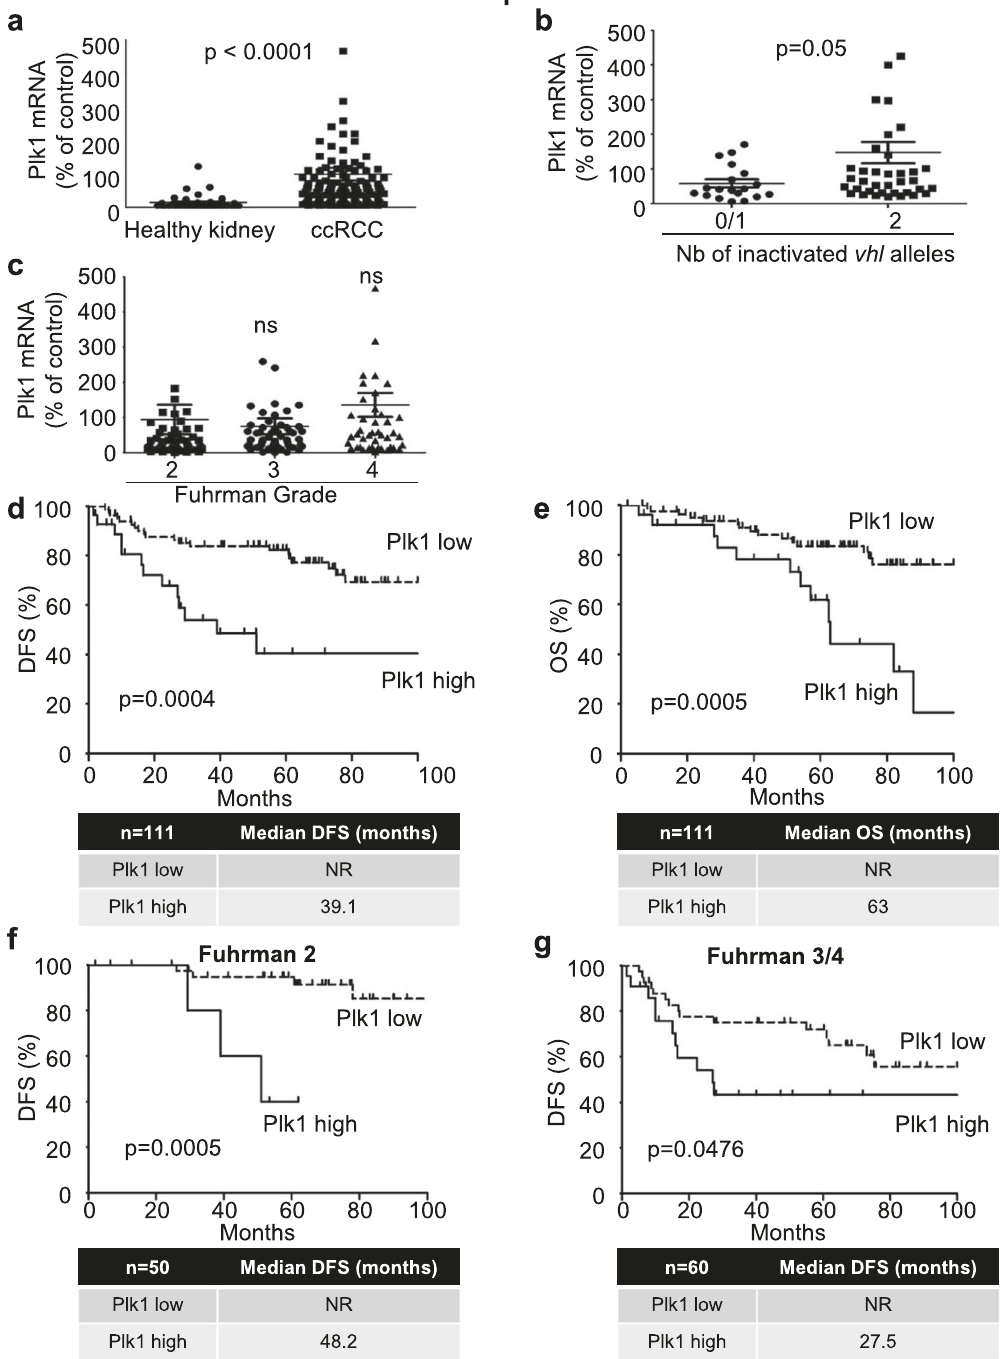
Fig. 1 Plk1 is associated with poor prognosis in ccRCC. 111 M0 ccRCC patients were analyzed for Plk1 mRNA levels in the kidneys (French cohort). a The levels of Plk1 mRNA in healthy kidney were compared with the levels in ccRCC. b The levels of Plk1 mRNA in ccRCC patients with VHL-WT (0 or 1 inactivated vhl allele) were compared to the levels in ccRCC patients with VHL-inactivated (2 inactivated vhl alleles). Vhl allele inactivation corresponds to a deletion, a mutation, or to a methylation of the promoter. c The levels of Plk1 mRNA were analyzed in different Fuhrman grade group (2 – 4). d , e The levels of Plk1 mRNA in 111 non-metastatic ccRCC patients correlated with DFS ( d ) or with OS ( e ). f , g The levels of Plk1 mRNA in non-metastatic low-grade (Fuhrman 2, f ) or high-grade (Fuhrman 3 and 4, g ) ccRCC patients correlated with DFS. The third quartile value of Plk1 expression was chosen as a cut-off. For ( a – c ), statistics were determined using an unpaired Student ’ s t test. For ( d – g ), the Kaplan-Meier method was used to produce survival curves and analyses of censored data were performed using Cox models. Statistical signi fi cance ( p values) is indicated (see Table 1).